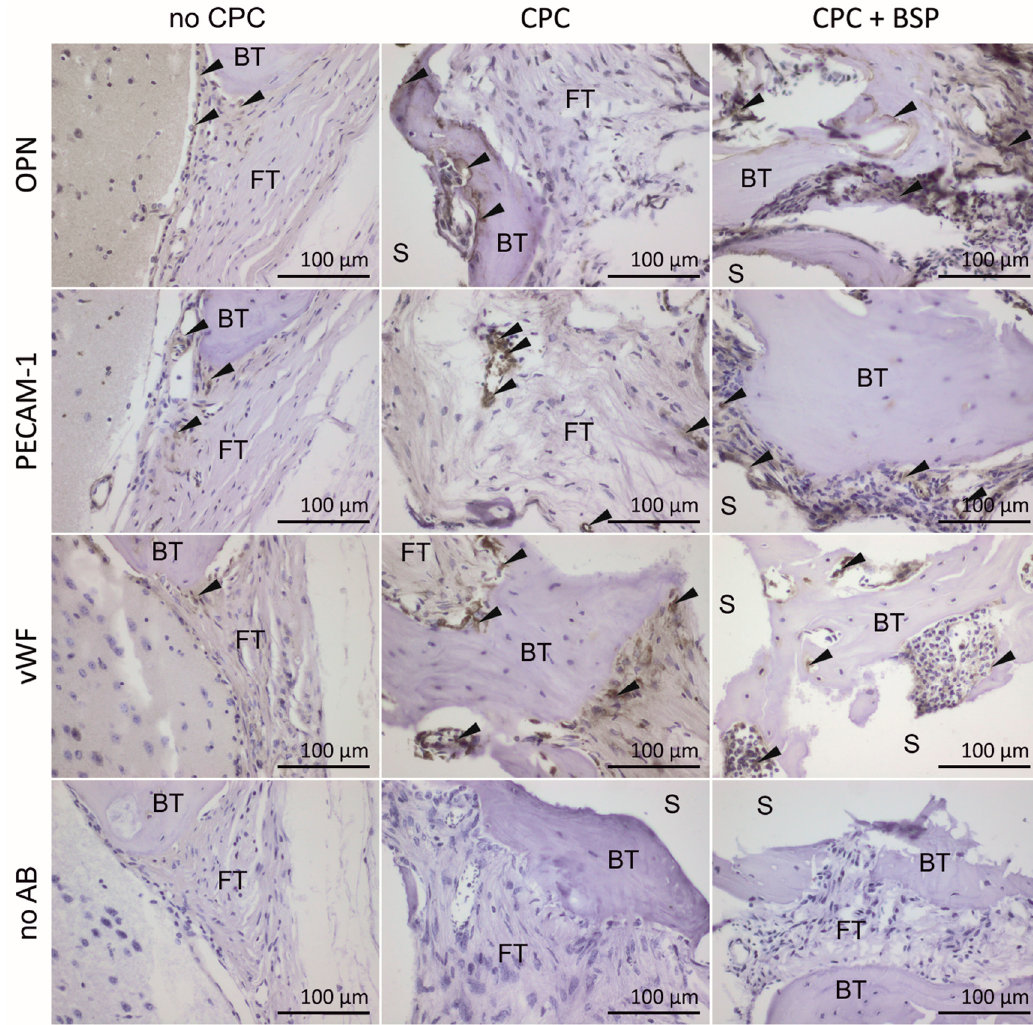
Figure 8. Immunohistological analysis of endothelial and osteoblast cell markers (von Willebrand factor (vWF), platelet endothelial cell adhesion molecule-1 (PECAM-1), and osteopontin (OPN)). Black arrows indicate positive staining (3,3'-diaminobenzidine (DAB) precipitate). Blood vessels in the scaffold’s pores were strongly positive for PECAM-1 and vWF, and were notably pronounced in the BSP group. Cells in contact with newly formed bone were positive for OPN, particularly in scaffolds with BSP coating. There were no stained areas in the sections with no antibody (no AB). FT: fibrous tissue. BT: bone tissue. S: scaffold.